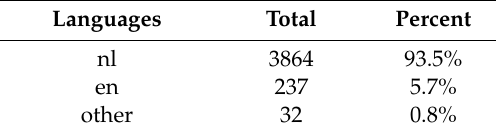
Table A39. Primary languages (nl).